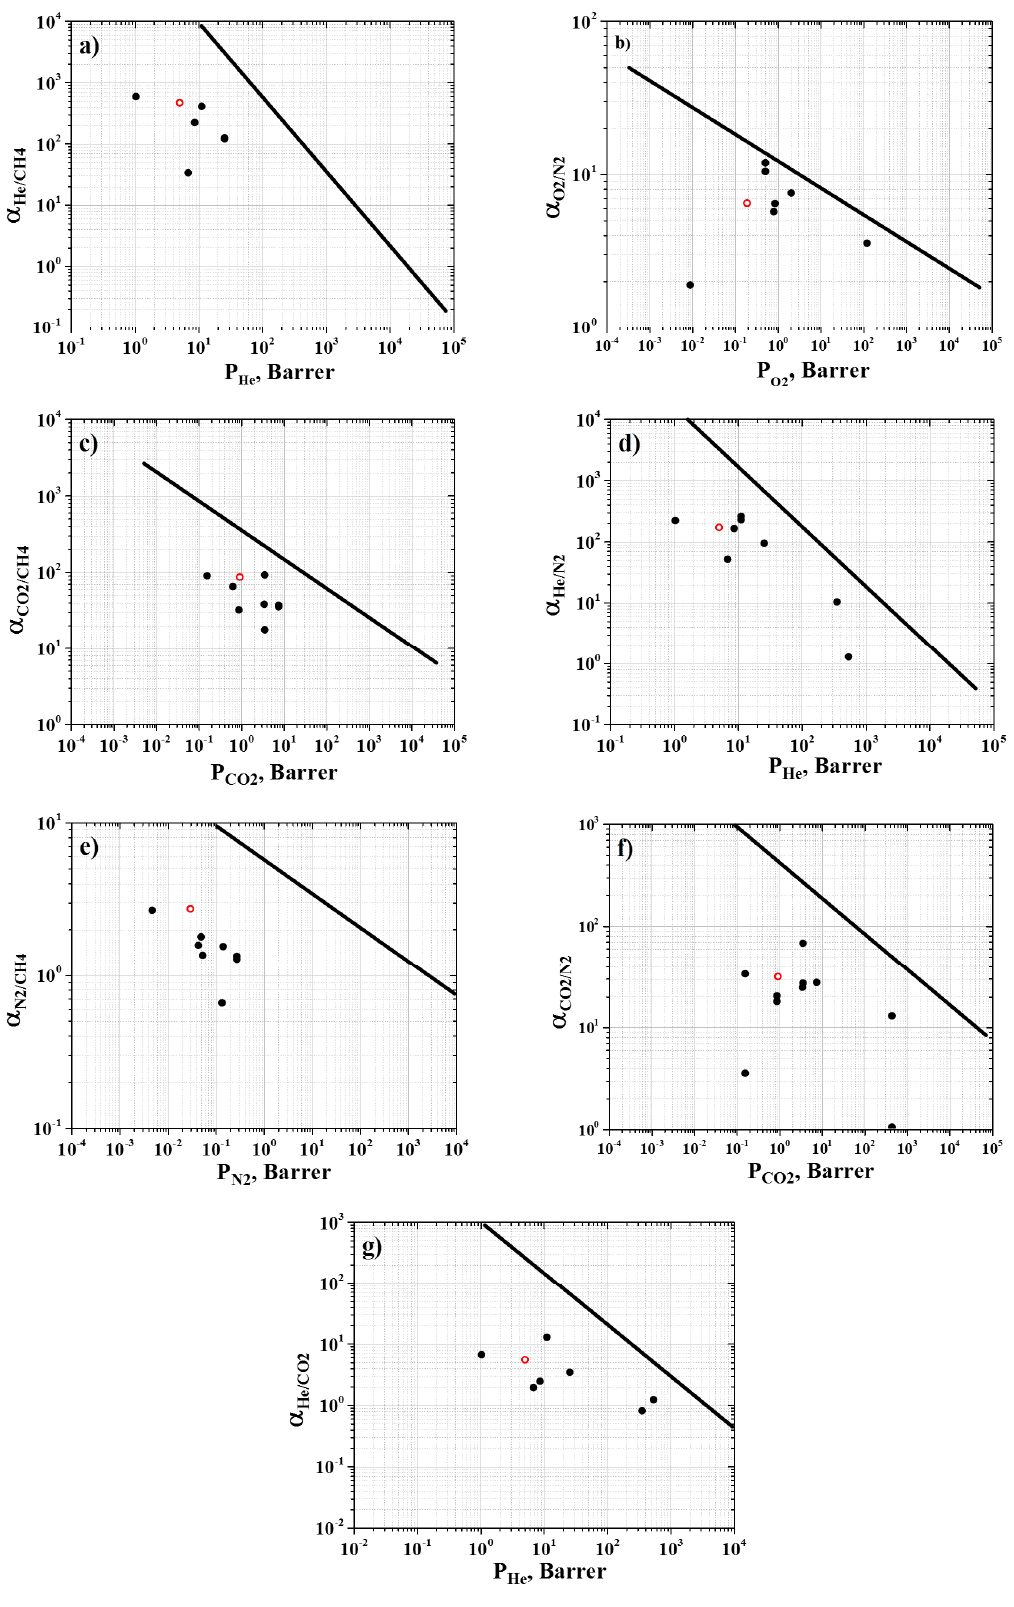
Figure 10. Robeson plots for ( a ) He / CH 4 , ( b ) O 2 / N 2 , ( c ) CO 2 / CH 4 , ( d ) He / N 2 , ( e ) N 2 / CH 4 , ( f ) CO 2 / N 2 , and ( g ) He / CO 2 . Solid black dots indicate data for commercial PIs available in the literature [13–20]. Open red symbols correspond to the experimental results on the transport properties of R-BAPB obtained in the present work. Solid lines indicate the Robeson upper bound [8].